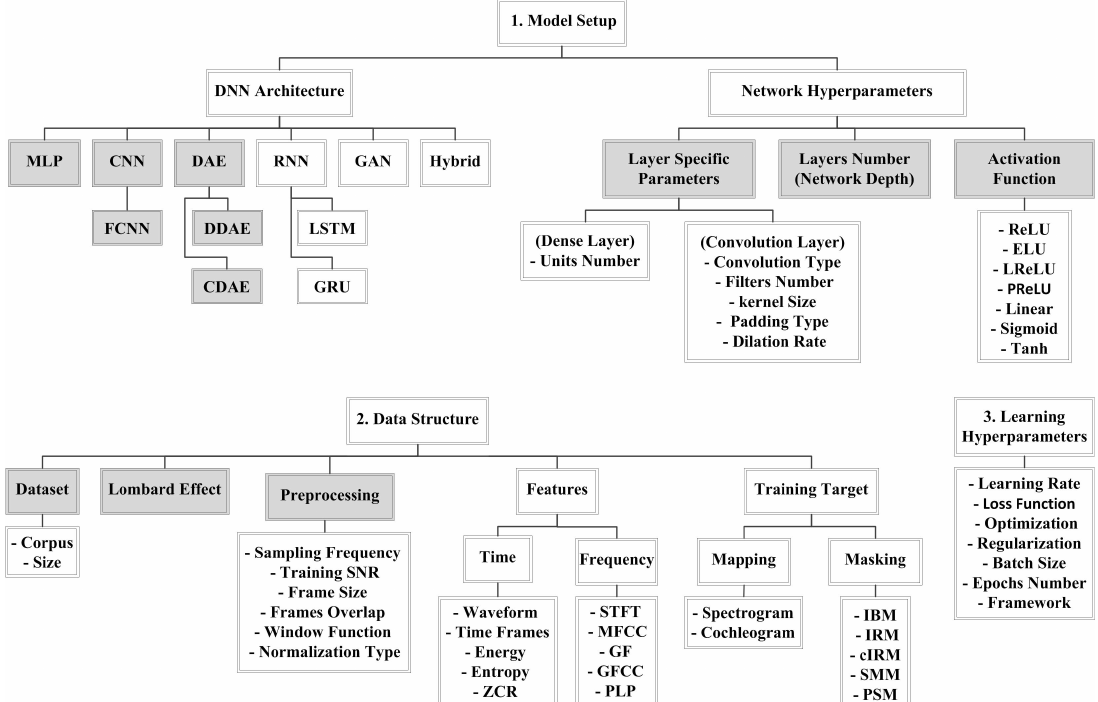
Figure 1. The three main factors affecting the performance of Deep Neural Networks (DNNs) for speech enhancement: Model Setup, Data Structure, and Learning Hyperparameters. The parts investigated in this study are shaded in grey. All acronyms are defined in Sections